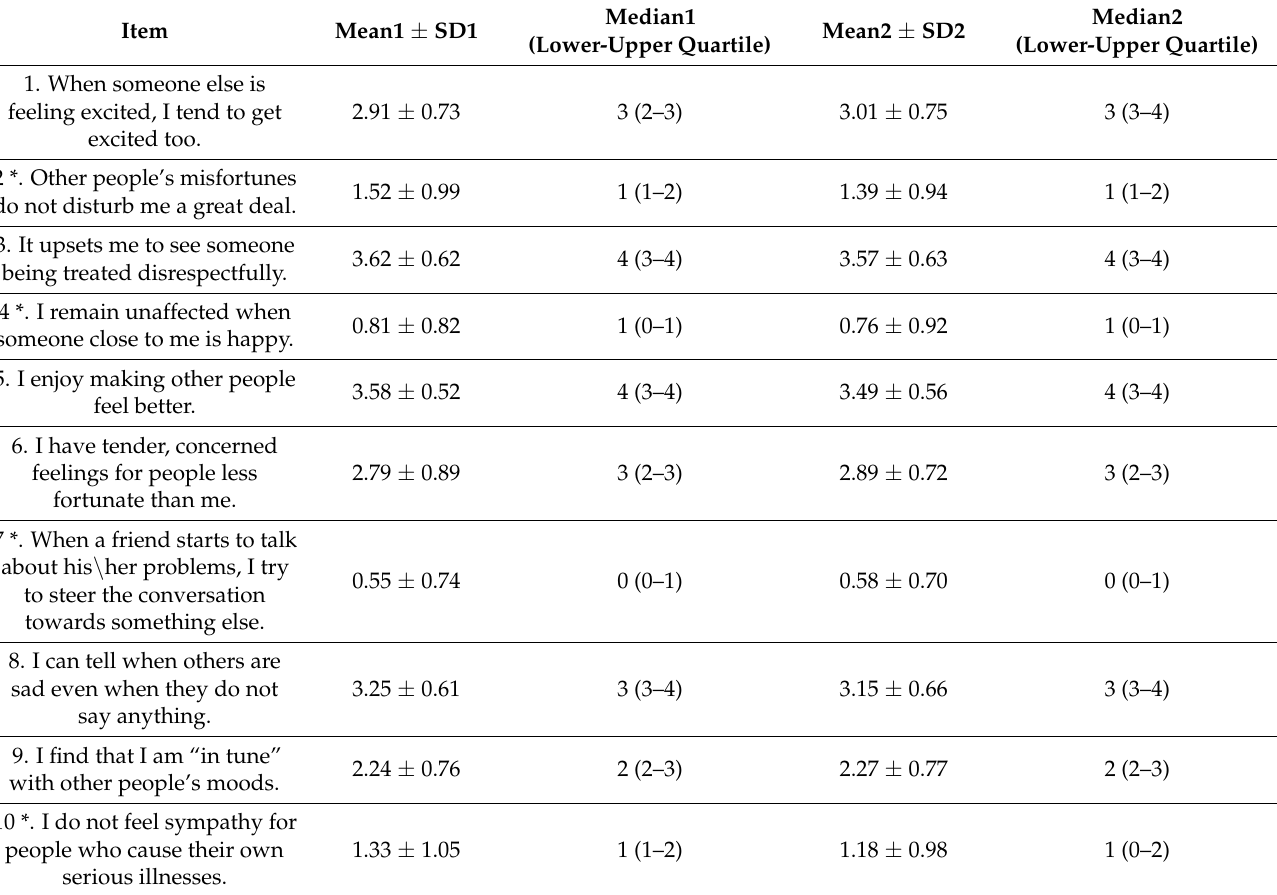
Table 2. Descriptive statistics for the TEQ items (test-retest) ( n =